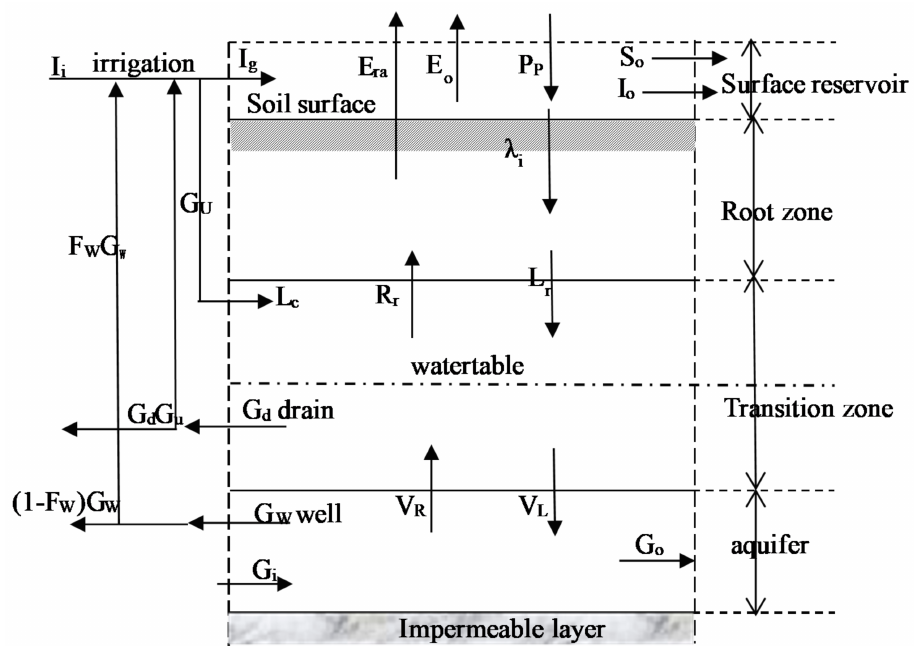
Figure 2. Soil reservoirs with hydrological inflow and outflow components. Note: P p is the amount of water vertically reaching the soil surface, such as precipitation and sprinkler irrigation; I i is the irrigation water supplied by the canal system; I g is the gross irrigation inflow including the natural surface inflow and the drain and well water used for irrigation, but excluding the percolation losses from the canal system; I 0 is the amount of irrigation water leaving the area through the canal system (bypass); E o is the amount of evaporation from open water; E ra is the amount of actual evapotranspiration from the root zone; λ i is the amount of water infiltrated through the soil surface into the root zone; λ 0 is the amount of water ex-filtrated through the soil surface from the root zone; the term λ 0 is not shown in Figure 2 as it can occur only when the water table is above the soil surface; S o is the amount of surface runoff or surface drainage leaving the area; L c is the percolation loss from the irrigation canal system; L r is the amount of percolation losses from the root zone; V R is the amount of vertical upward seepage from the aquifer into the transition zone; V L is the amount of vertical downward drainage from the saturated transition zone to the aquifer; R r is the amount of capillary rise into the root zone; G w is the amount ground water pumped from the aquifer through wells; G d is the total amount of subsurface drainage water; G i and G o are the horizontally incoming/outgoing ground water flow into a polygon through the aquifer; F w is the fraction of the pumped well water G w used for irrigation and G u is the quantity of subsurface drainage water used for irrigation. F w G w and G u were negligible and were set equal to zero in this study. ∆ W s is the change in the amount of water stored in the surface